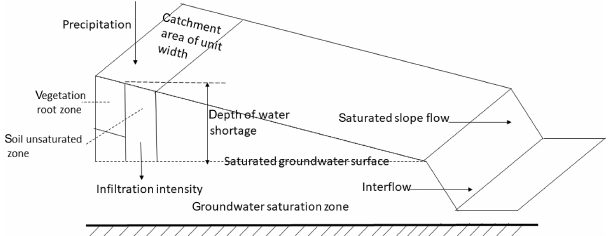
Figure 3. Conceptual framework of TOPMODEL.